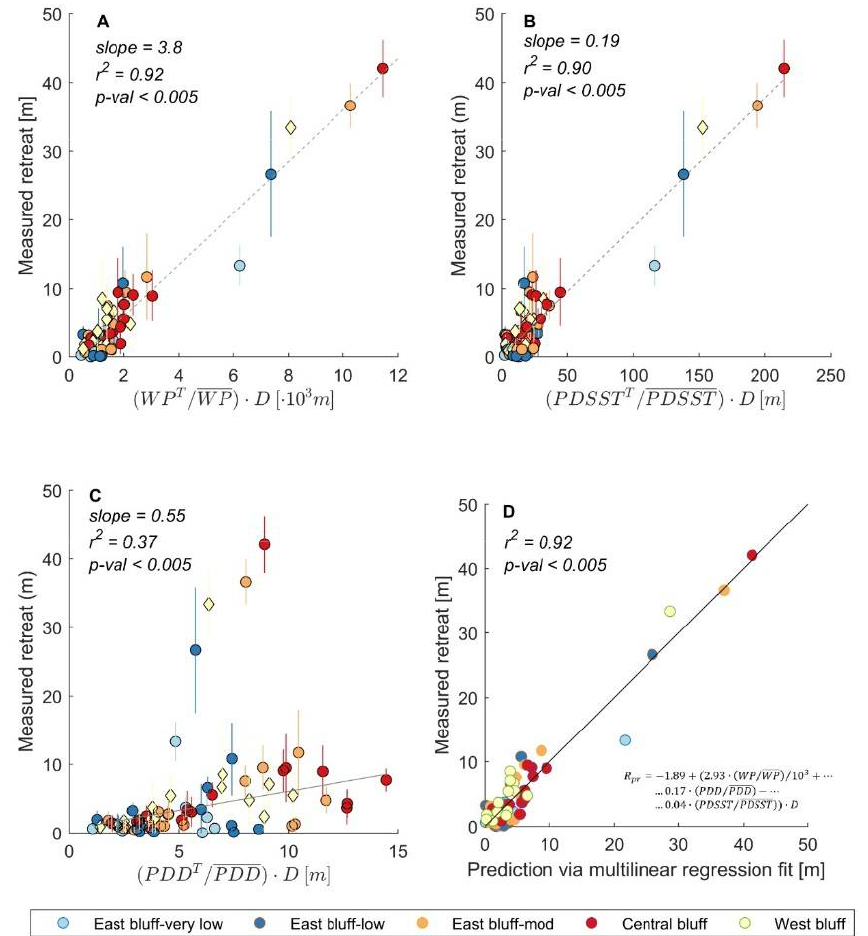
Figure 12. Relationship between bluff recession and physical drivers multiplied by bluff heights. ( A ) Normalized cumulative wave power (WP), ( B ) normalized cumulative positive degree days (PDD), ( C ) normalized cumulative degree day positive sea surface temperatures (PDSST), and ( D ) linear fit of multiple linear regression between all three physical parameters and measured retreat for 17 distinct time periods between 1979 and 2019, when both bluff recession and physical driver data were available. Solid line in D is the 1:1 perfect fit; dashed lines in ( A – C ) are the least-squares linear fit lines (excluding outliers for